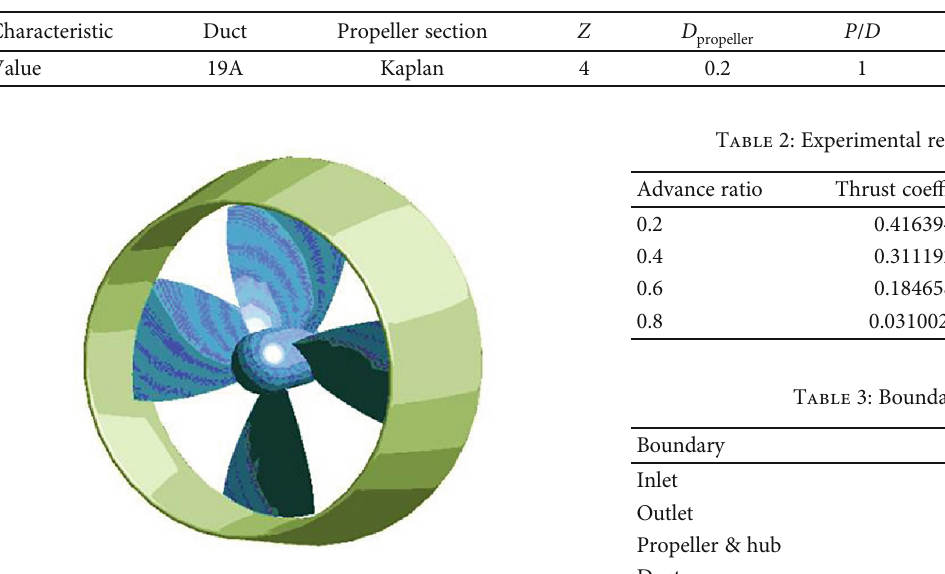
Figure 1: Three-dimensional model of the ducted propeller.